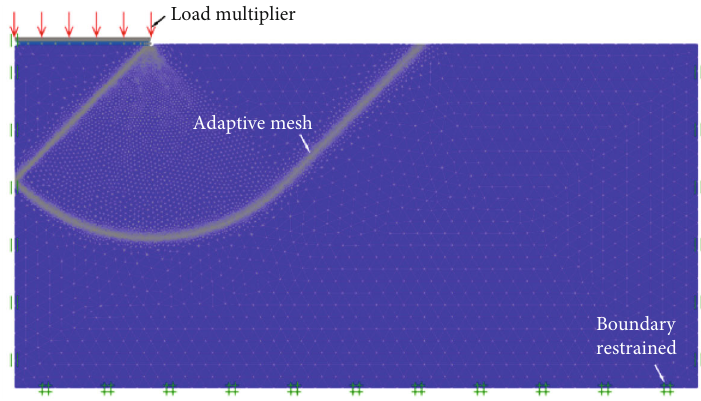
Figure 1: Numerical model of a circular foundation. Table 1: Bearing capacity coe ffi cient N